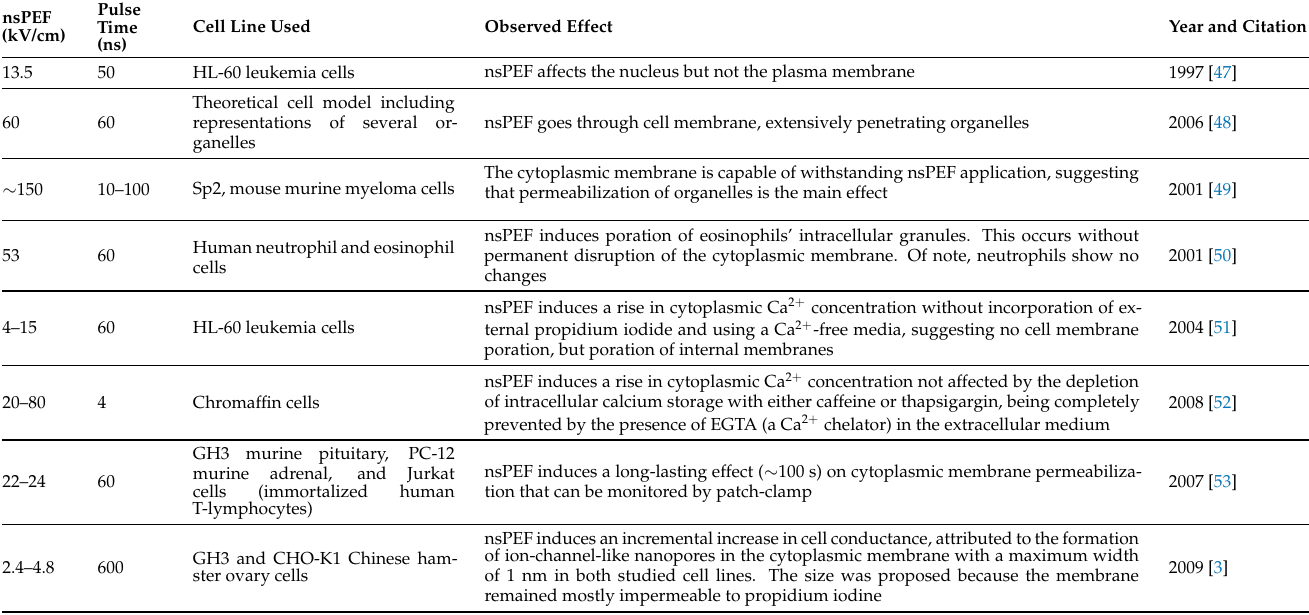
Table 1. Examples of both theoretical and experimental studies exploring nanopore formation upon the application of